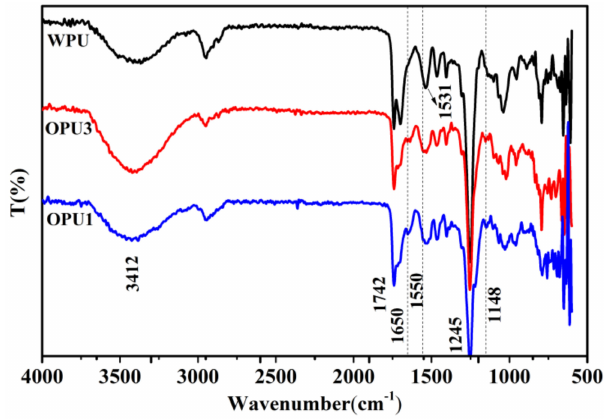
Figure 1. FTIR spectra of WPU and